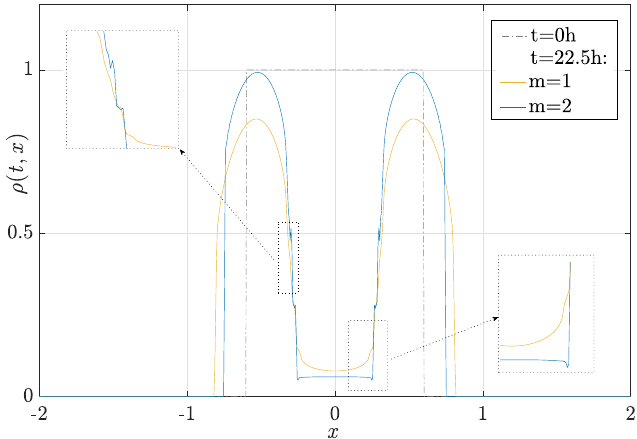
Figure 5. Comparative of poroelastic parameter m = 1,2 at t = 22.5